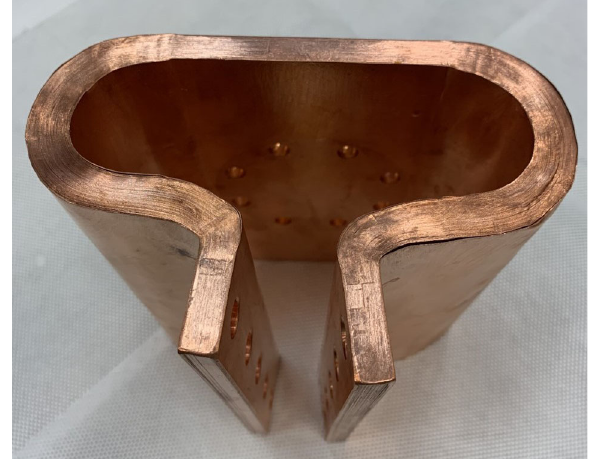
ð T Þ in the normal state measured for the FIG. 16. R s Cu = Nb = Nb 3 Sn cavity. The solid line is a least-square fit with the real part of Eq. (1).